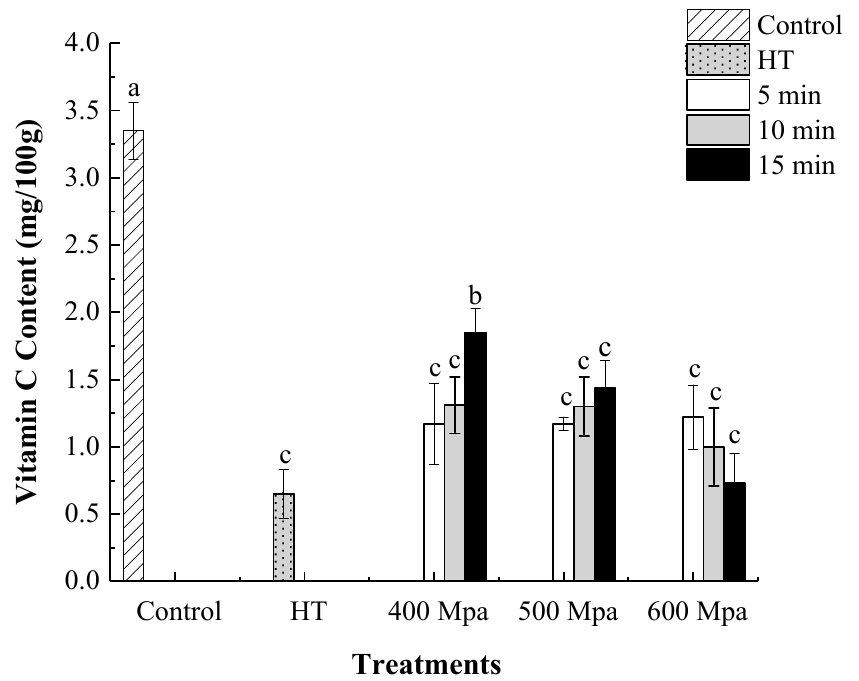
Figure 1. Vitamin C content of HHP-treated and heat-treated kiwifruit pulp beverage after 0 day. Figure1. VitaminCcontentofHHP-treatedandheat-treatedkiwifruitpulpbeverageafter0day. Control Control (kiwifruit pulp beverage treated without heat treatment (HT) or HHP). HT (85 °C for 10 min), (kiwifruit pulp beverage treated without heat treatment (HT) or HHP). HT (85 ◦ C for 10 min), HHP HHP (high hydrostatic pressure, 400–600 MPa for 5–15 min). Values with different letters are (high hydrostatic pressure, 400–600 MPa for 5–15 min). Values with di ff erent letters are significantly di ff erent ( p < 0.05). All data were expressed as means ± SD, n = significantly different ( p < 0.05). All data were expressed as means ± SD, n = 3.